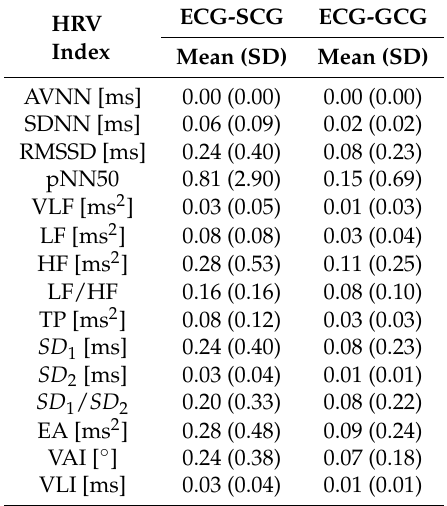
Table 5. Mean and standard deviation of relative error of HRV indices calculated on signals divided into overlapping 179 s time windows.